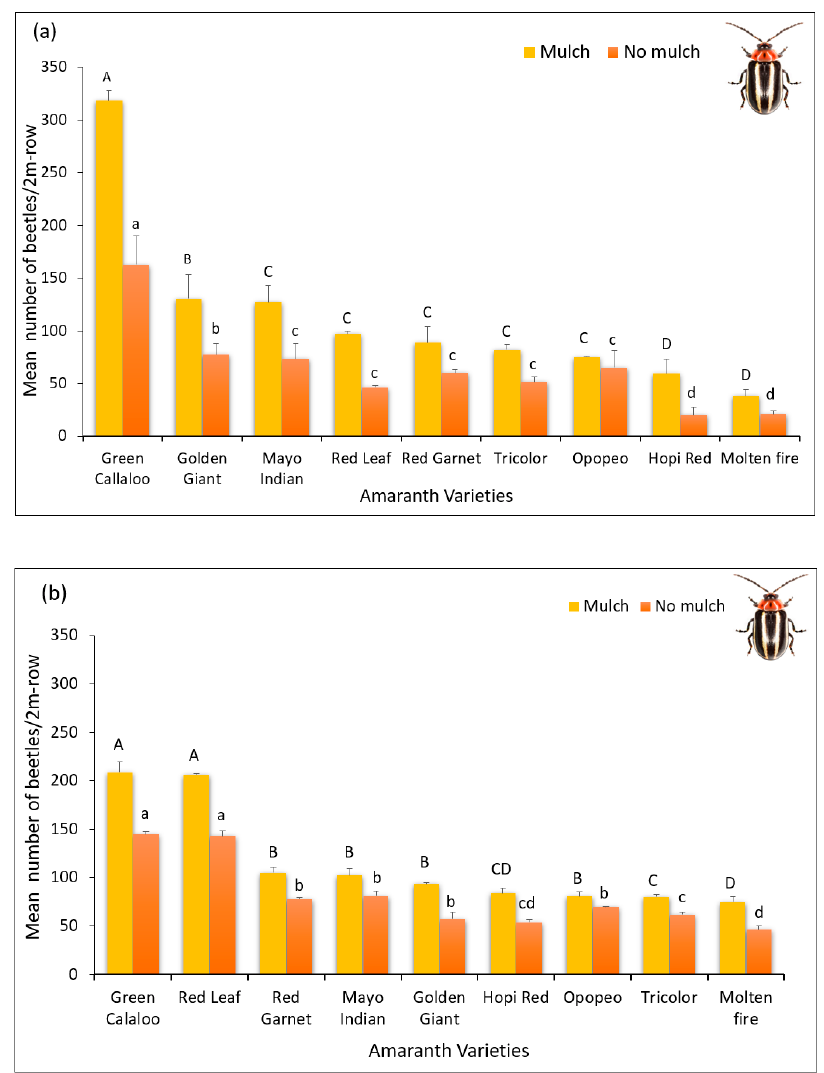
Figure 2. D . glabrata population (Mean ± SE) in mulched and no mulched plots in 2017 ( a ) and 2018 ( b ). Different uppercase letters on bars indicate significant difference among varieties within mulch plot treatment, while different lowercase letters above bars indicate significant difference among varieties within no mulch plot treatment (Fisher’s LSD; p <